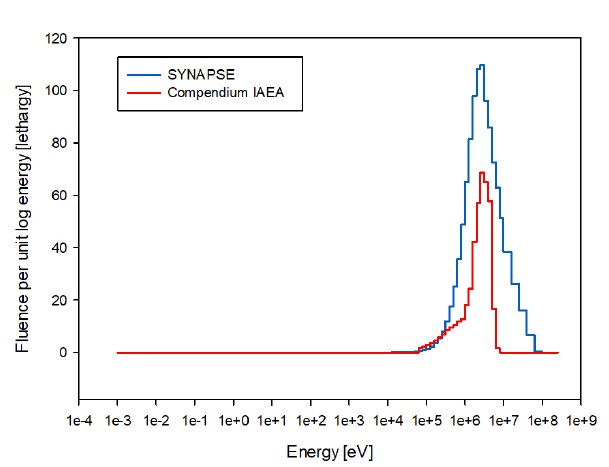
Figure 13. Neutron spectrum unfolding of a 239 P uBe neutron source